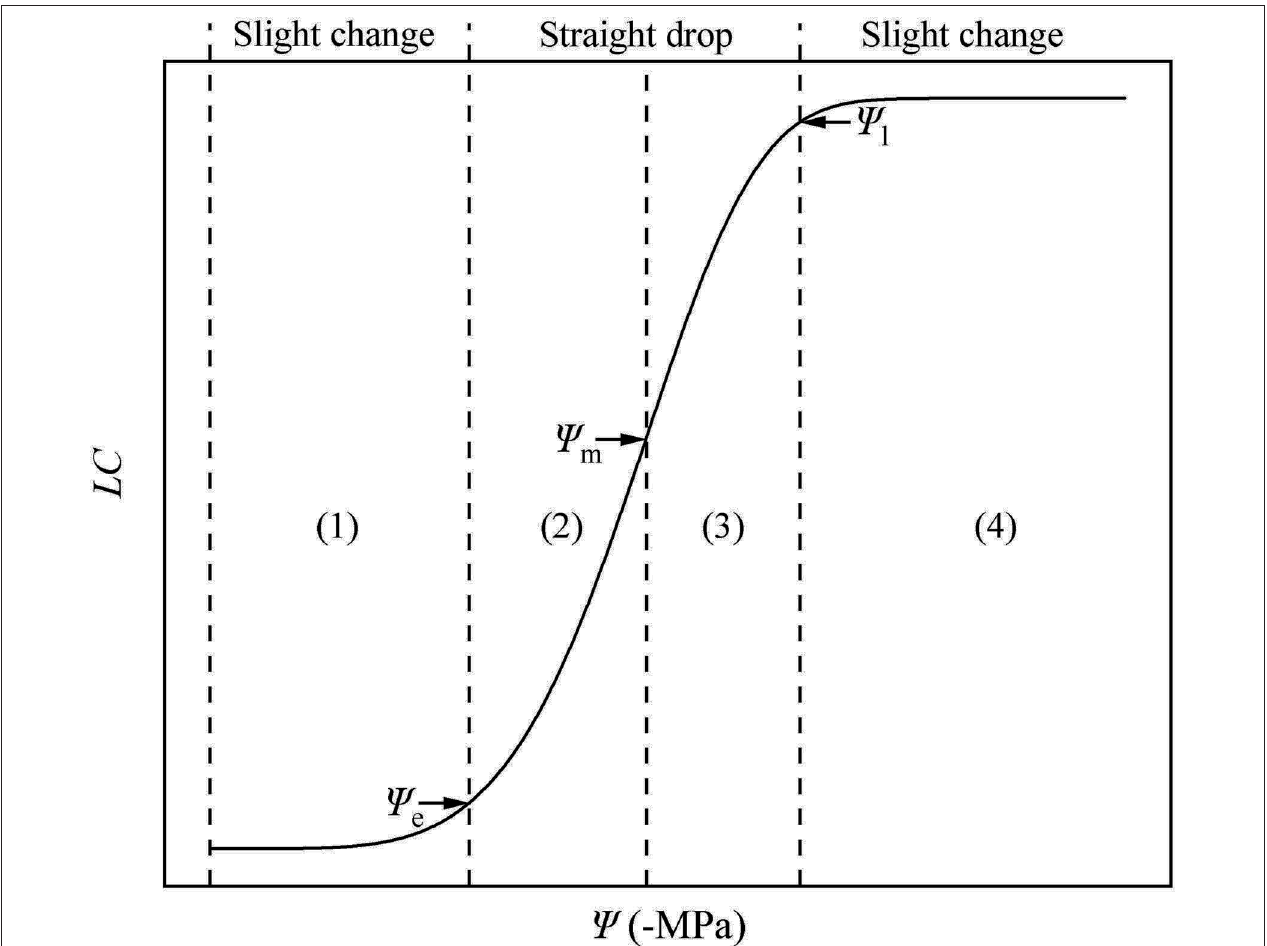
FIGURE 7 | Hydraulic vulnerability curve diagram. The water potential is represented by Ψ , and the loss of conductivity is represented by LC . There are four periods in the HVC: (1) stationary period, (2) accelerated decline period, (3) decelerated decline period, (4) and platform period. These are separated by three key points: air-entry point ( Ψ e ), fastest drop point ( Ψ m ), and upper inflection point ( Ψ l